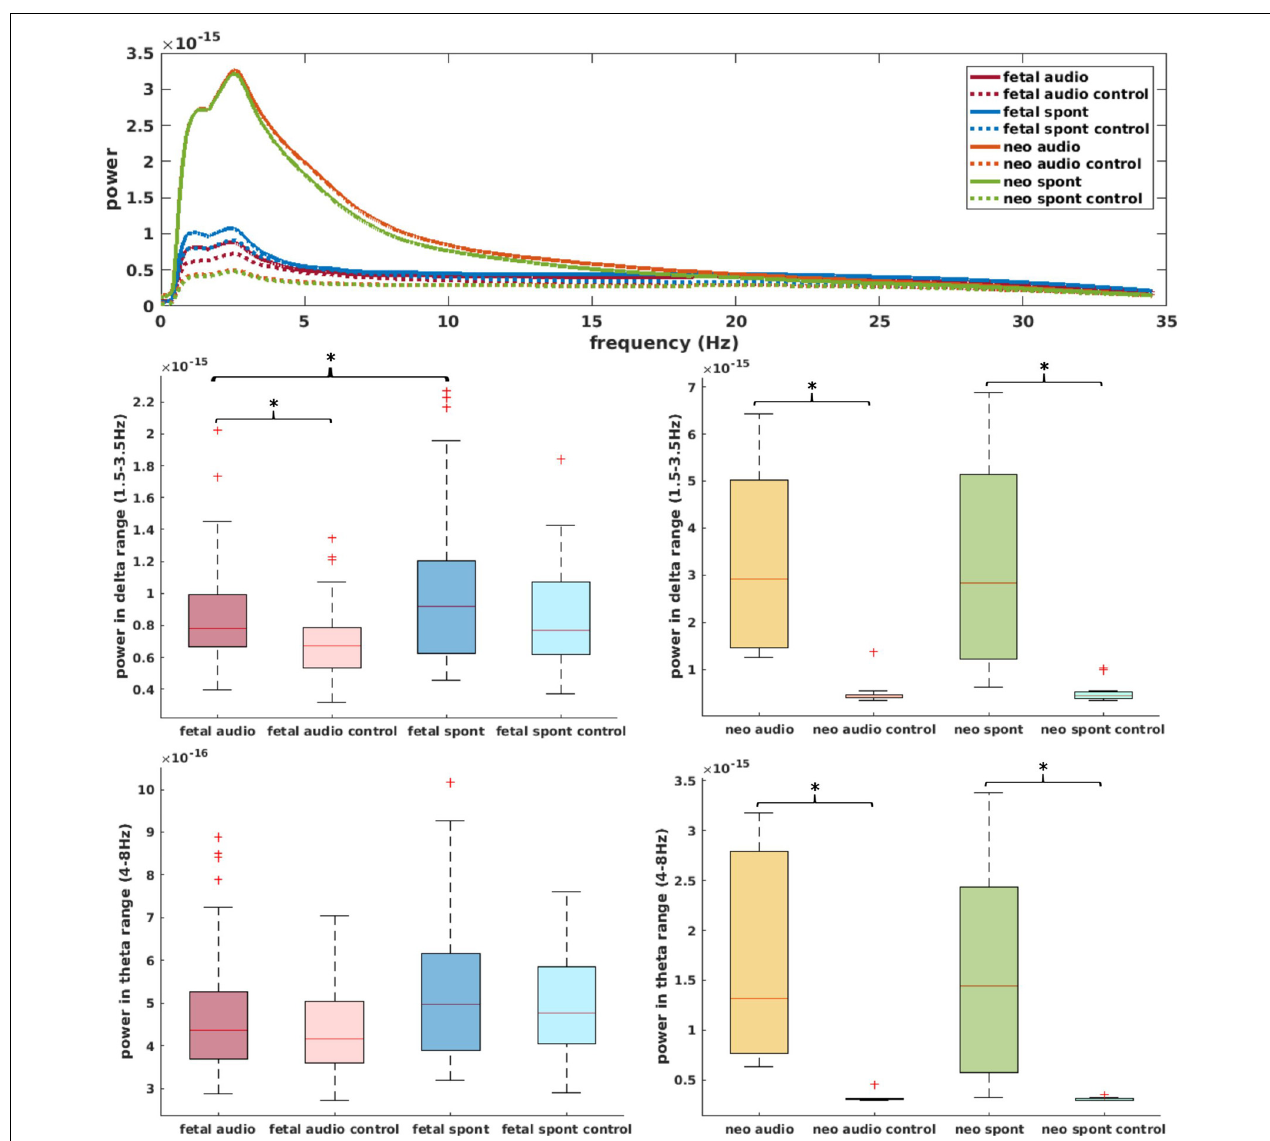
FIGURE 5 | Top: power spectral density of data used for current analysis (data smoothed over 200 data points for better visibility); solid lines represent brain channels, dotted lines control channels. Middle: comparison of power in delta range for fetal (left) and neonatal (right) data. Bottom: equivalent for theta range. ∗ Depicts significant difference ( p =